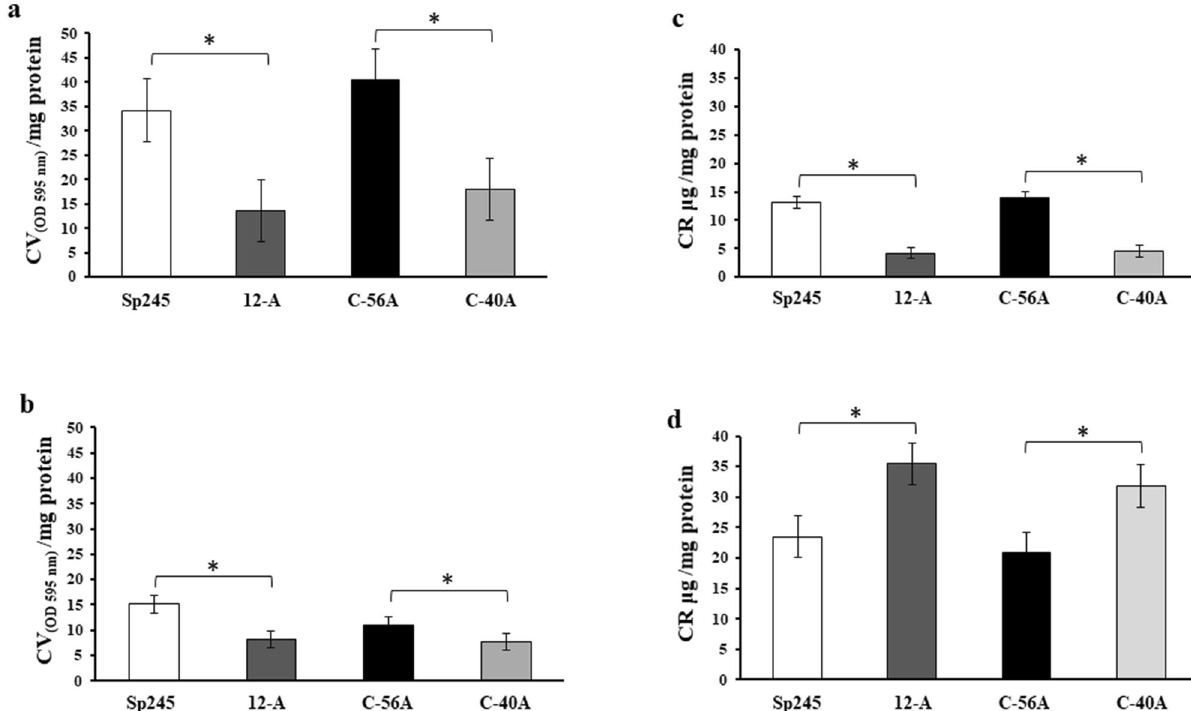
Figure 2. Effects of the mutation of the cdgD gene on biofilm and EPS production determined in the A. brasilense WT and derivative strains. ( a ) Determination of biofilm formation in NFB* medium supplemented with KNO 3 via the quantification of CV/mg protein values. ( b ) Determination of biofilm formation in NFB* supplemented with NH 4 Cl medium via the quantification of CV/mg protein values. ( c , d ) Determination of EPS production in the media described above via the quantification of CR/mg protein values in a staining assay. Wild type (Sp245), isogenic mutant (12-A), complemented mutant (C-56A), and empty vector mutant (C-40A). Error bars represent the standard deviations of three biological replicates, and statistically significant differences are indicated at * P < 0.05 according to Student’s t-test by SigmaPlot (Systat Software, San Jose,